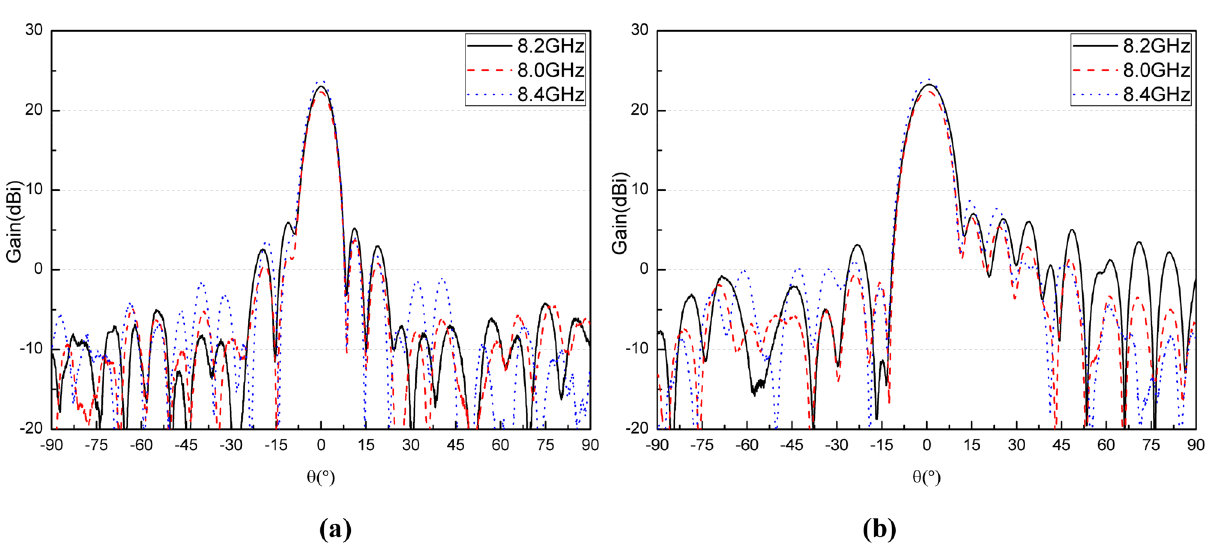
Figure 12. Comparison of measured gain radiation patterns at three frequencies: (a) the elevation and (b) the